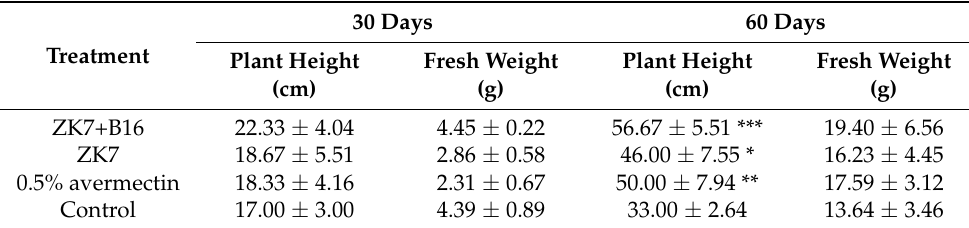
Table 6. Effects of different treatments on plant height and fresh weight of tomato (collected in pot experiments).